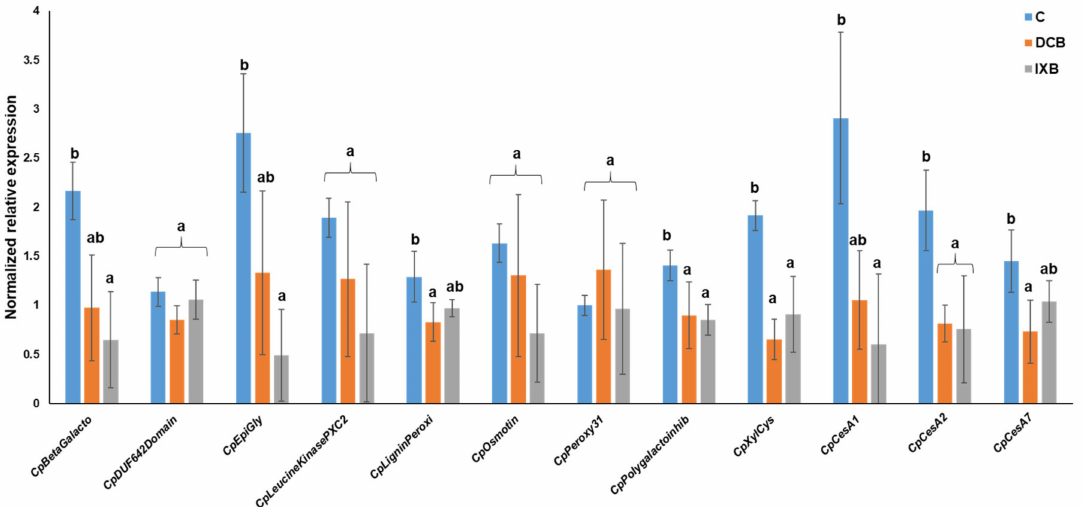
Figure 6. Gene expression analysis of control (indicated with C) and habituated cells (indicated with DCB and IXB). Values are expressed as the mean ± standard deviation (SD) from four independent biological replicates. Different letters indicate statistically significant differences ( p -value < 0.05) at the one-way ANOVA with Tukey’s post-hoc test or at the Kruskal-Wallis with Dunn’s post-hoc test. CpBetaGalacto [F(2,9) = 7.00, p -value = 0.015], CpDUF642Domain [F(2,9) = 3.57, p -value = 0.072], CpLigninPeroxi [F(2,9) = 5.21, p -value = 0.031], CpPeroxy31 [F(2,9) = 0.51, p -value = 0.618], CpXylCys [F(2,9) = 10.04, p -value = 0.005], CpEpiGly [X 2 (2) = 8.35, p -value = 0.015], CpLeucineKinasePXC2 [X 2 (2) = 3.73, p -value = 0.155], CpOsmotin [X 2 (2) = 3.50, p -value = 0.174], CpPolygalactoinhib [X 2 (2) = 6.58, p -value = 0.037], CpCesA1 [F(2,9) = 7.53, p -value = 0.012], CpCesA2 [F(2,9) = 8.35, p -value = 0.009], CpCesA7 [F(2,9) = 6.05, p -value =